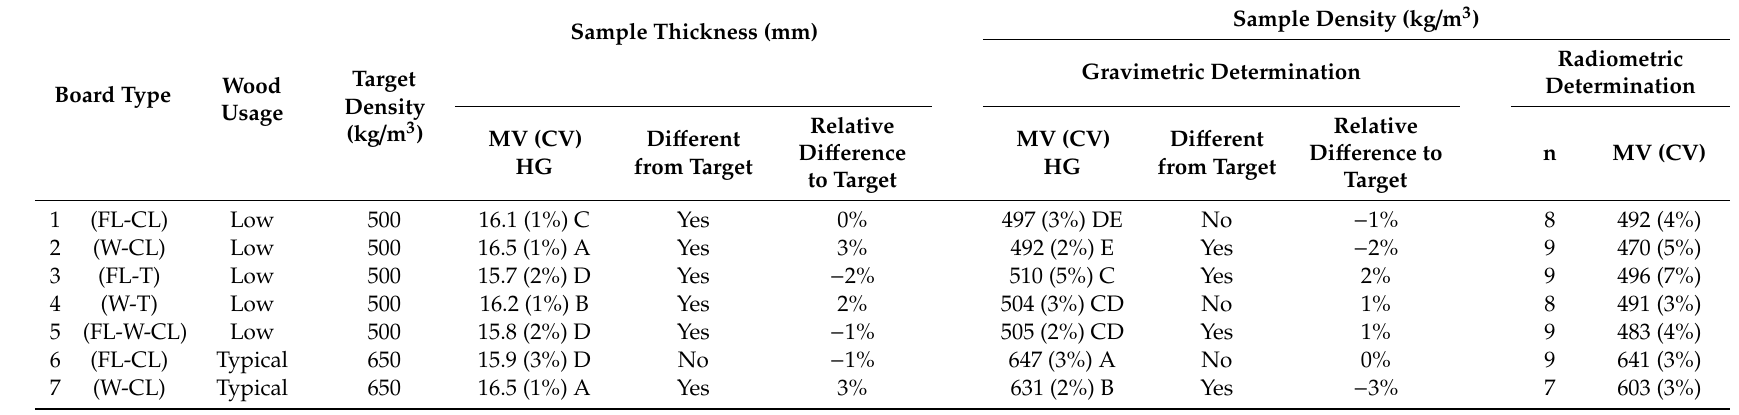
Table 6. Statistical characteristic values (MV, coe ffi cient of variance (CV)) of the sample thickness, gravimetrically determined sample density (both n = 51), and radiometrically determined sample density ( n = 7 ... 9), results (homogeneous group (HG), indicated by letters) of statistical mean value comparison, results of statistical testing for achievement of target thickness and density, and information on the relative di ff erence between target and actual